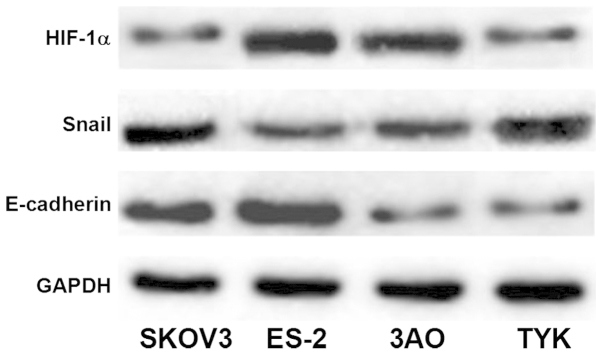
Protein expression of HIF-1α, Snail and E-cadherin in ovarian cancer cells. Western blot analysis of HIF-1α, Snail and E-cadherin in SKOV3, ES-2, 3AO and TYK ovarian cancer cells. Equal loading of protein was confirmed by GAPDH. HIF-1α, hypoxia-inducible factor-1α.